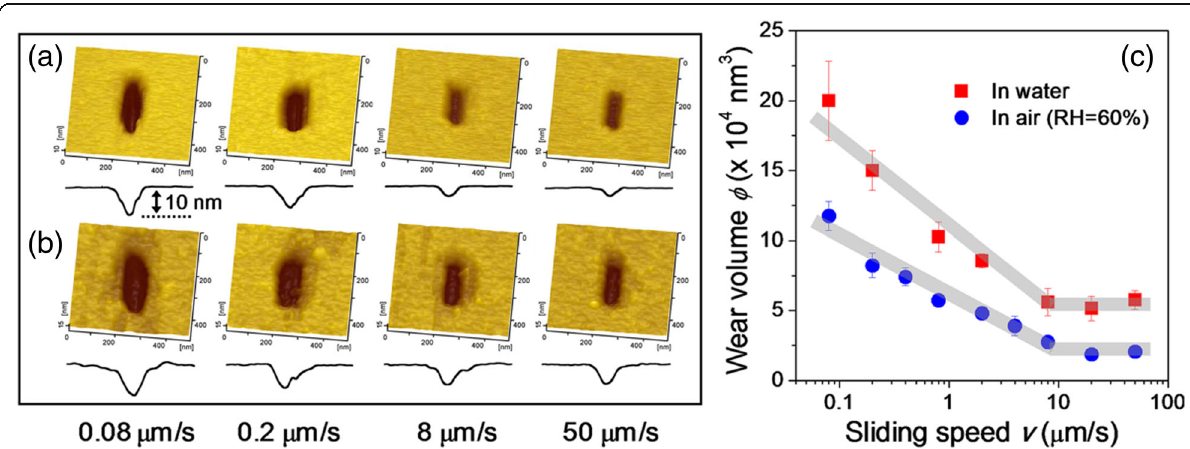
Fig. 1 AFM images and the corresponding cross-section profiles of wear scar on silicon surface slid against SiO 2 tip at sliding speed ranging from 0.08 to 50 μ m/s in humid air (RH = 60%) ( a ) and in water ( b ). Volume of wear scars on Si surface as a function of sliding speed in air and in DI water ( c ). Imposed load is 2 μ N, sliding amplitude is 200 nm, and the number of sliding cycles is